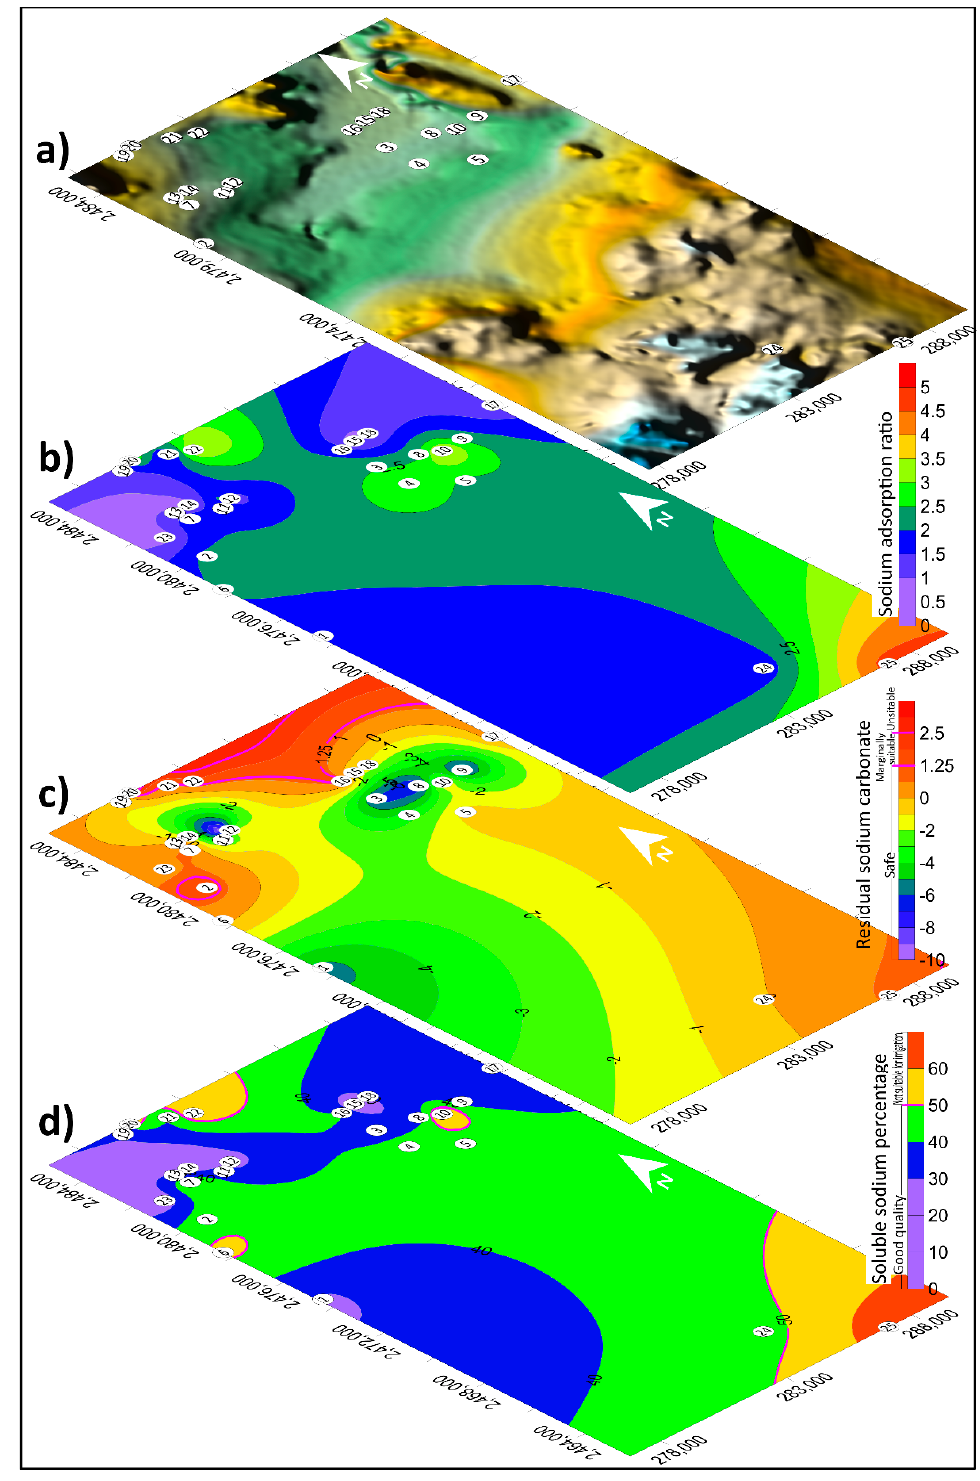
Figure 5. ( a ) Topographic relief of the study area; spatial distribution of ( b ) SAR, ( c ) RSC, and ( d )